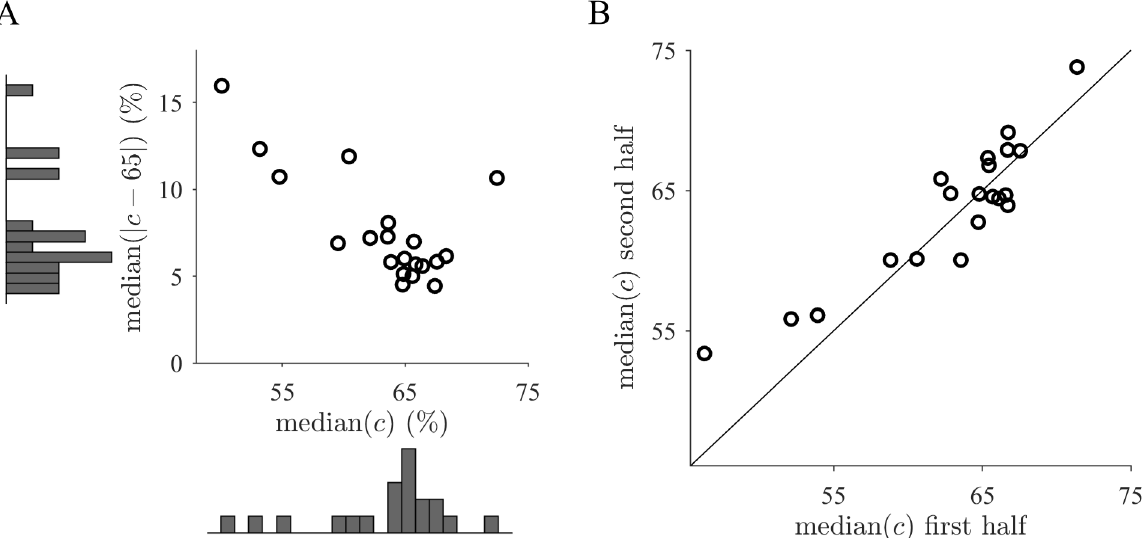
Fig 4. Behavior is consistent with participants possessing a subjective but well calibrated trial-by-trial internal objective that remains stable over the experiment. ( A ) Across trials participants tend to comply well to the objective despite per trial deviations due to systematic biases and response noise, as the capture percentage c is typically around the target value 65% (vertical axis) and the median deviance is relatively small (horizontal axis). Histograms correspond to marginal distributions. ( B ) Participants display stable behavior throughout the experiment, as they do not appear to adjust their responses closer to the task objective over time. Median capture percentages c are calculated separately for the first and second halves of the experimental session.